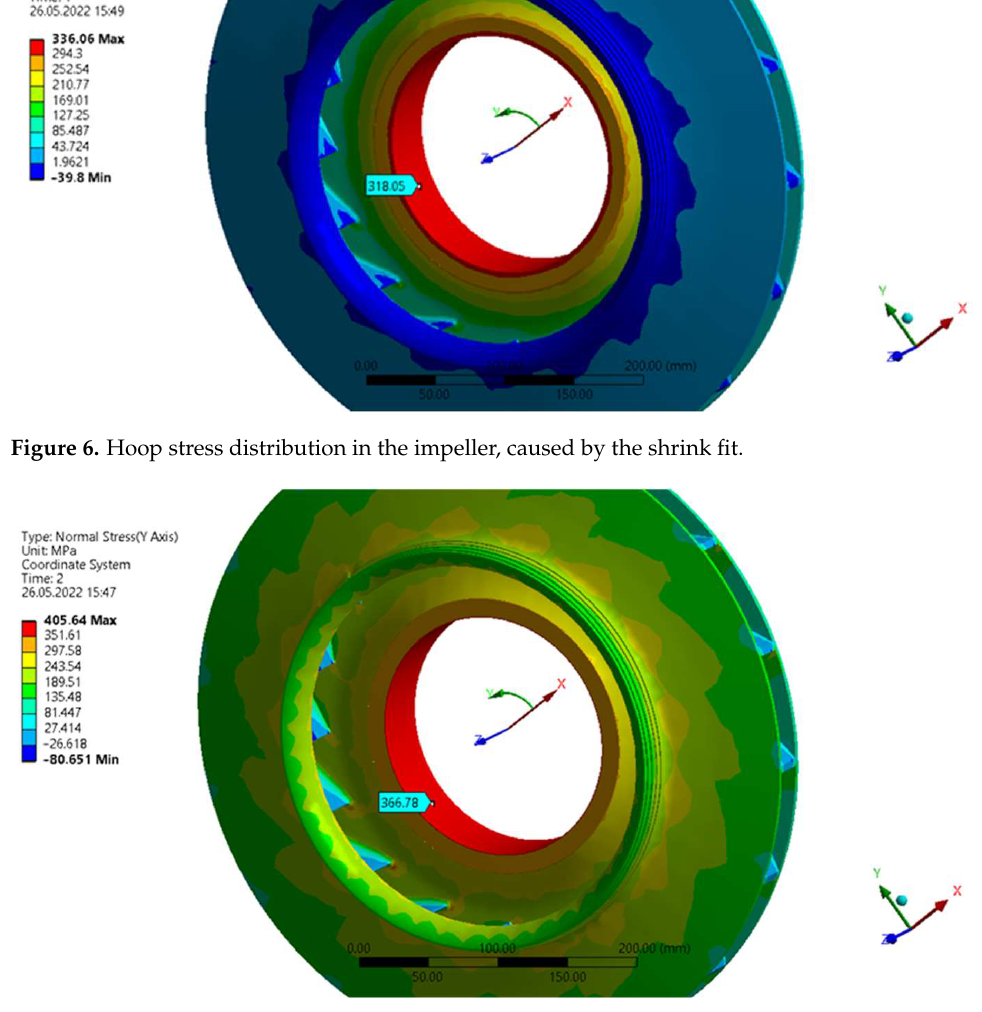
Figure 7. Hoop stress distribution induced by the centrifugal force and the shrink fit.